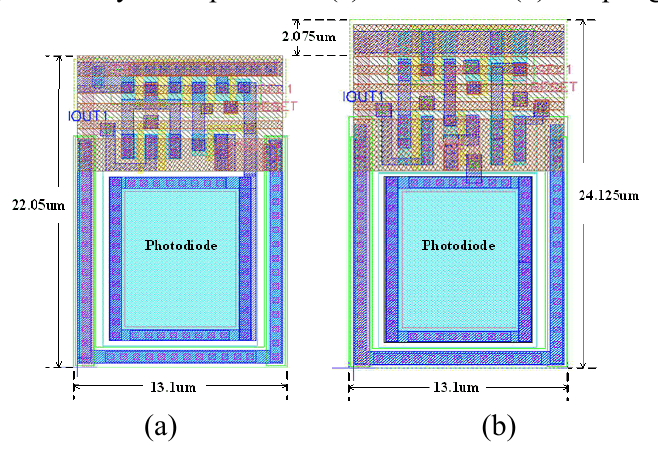
Figure 6. Layout of pixel cell (a) normal cell (b) sampling cell.